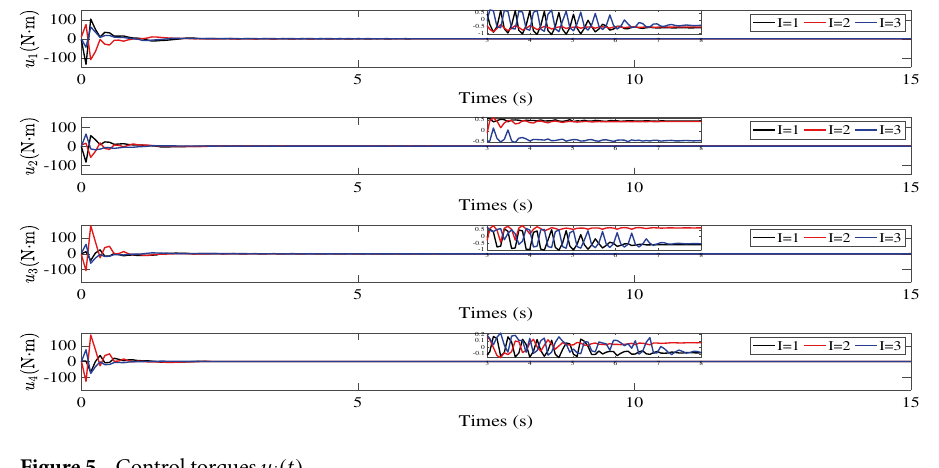
Figure 5. Control torques u i ( t )